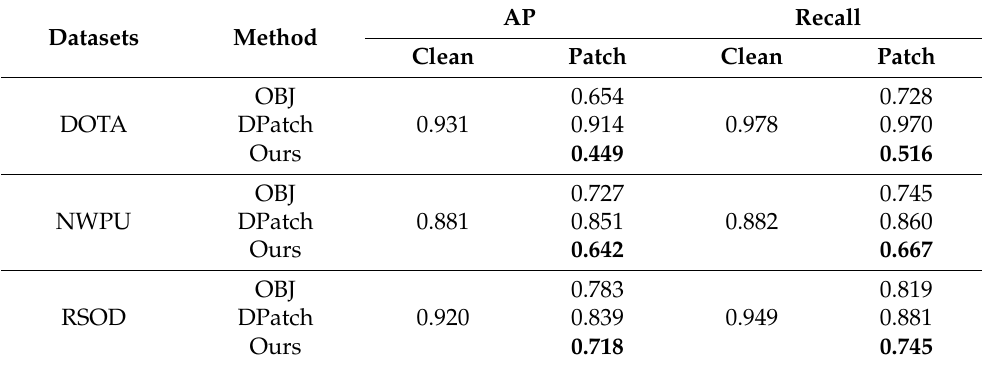
Table 1. Comparison of the attack effect of our method with that of other methods. The evaluation metrics are AP and